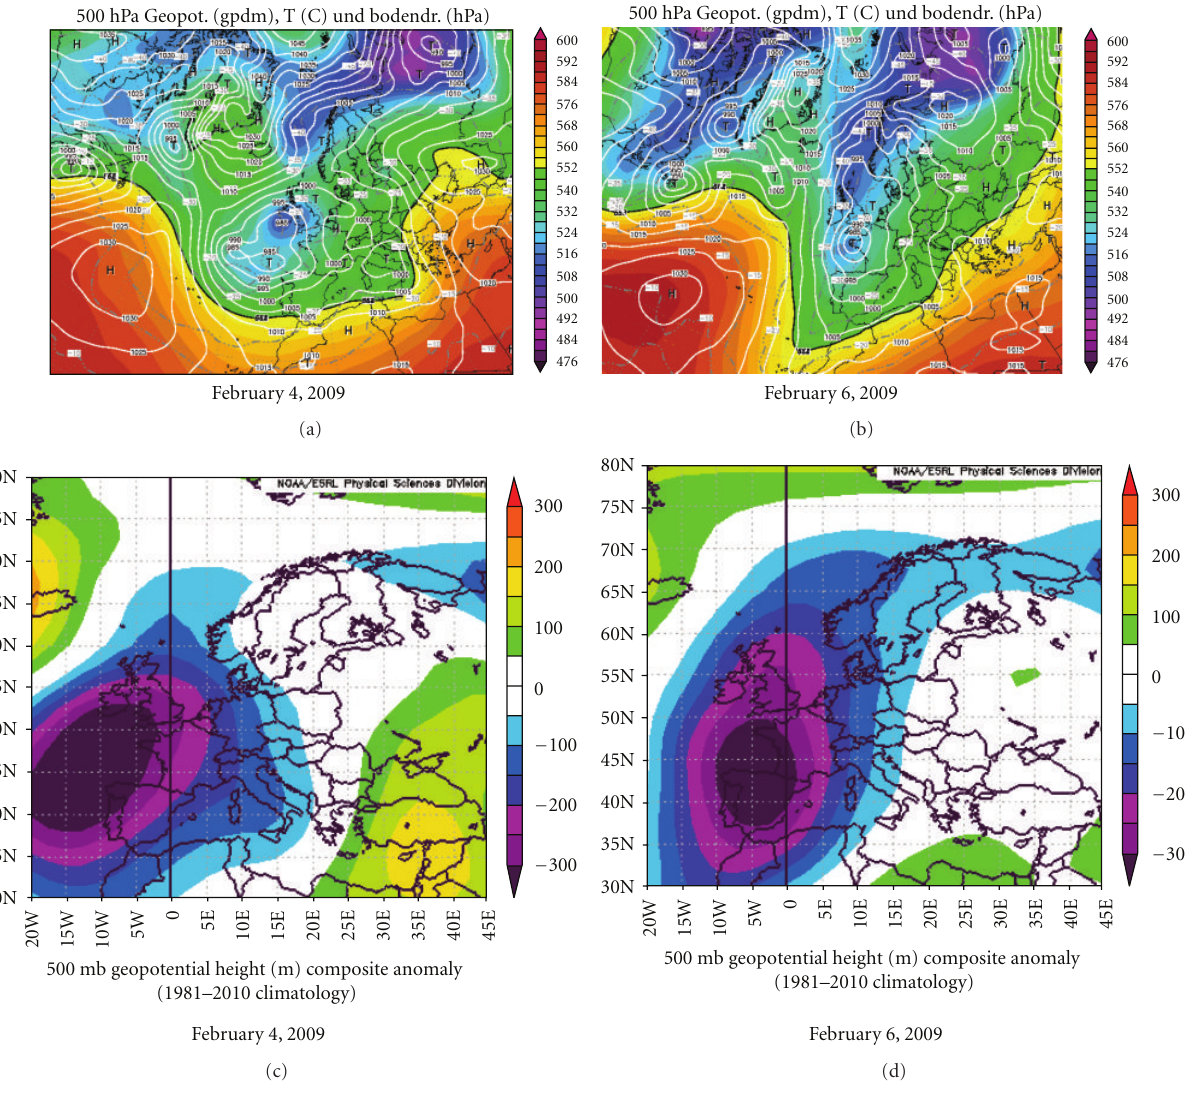
Figure 10: Spatial distribution of geopotential heights (m) for 500hPa level along with surface barometric pressure (hPa) ((a) and (b)) and composite anomaly from 1981–2010 Climatology of the geopotential heights (m) at 500 hPa level ((c) and (d)) during the Saharan episodes on February 4, 2009 ((a) and (c)) and February 6, 2009 ((b) and (d)), using NCEP/NCAR reanalysis